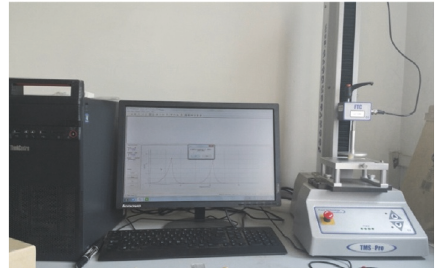
Figure 2: The texture